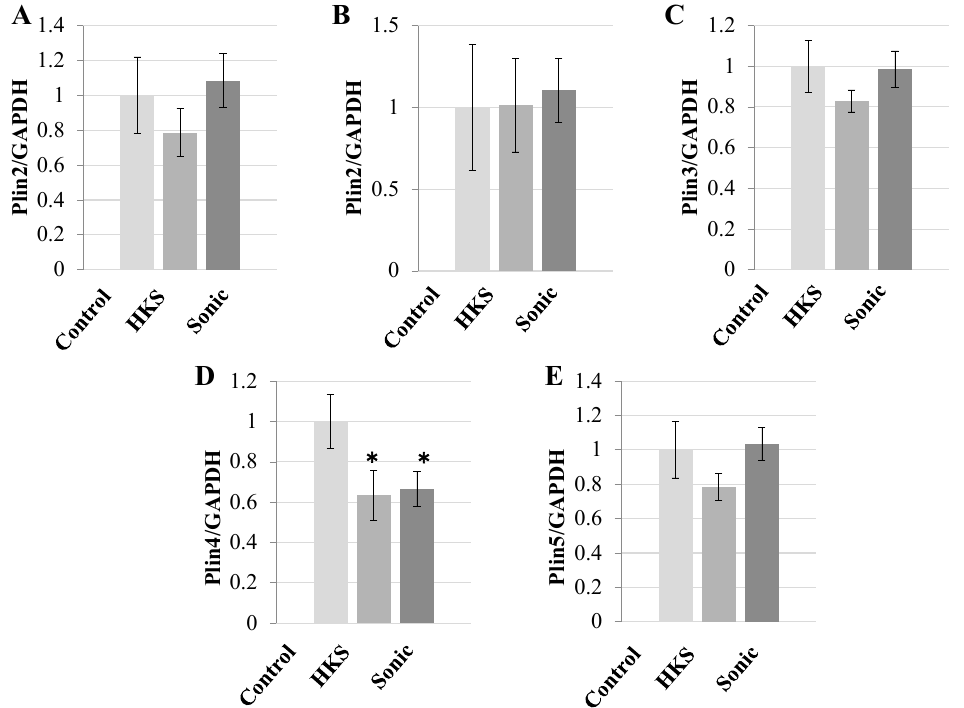
Figure 1. The effects of Bifidobacterium breve MCC1274 extract on perilipin gene expression in SH-SY5Y cells. The SH-SY5Y cells were exposed to B. breve MCC1274 heat-killed supernatant (HKS) or sonicated supernatant (Sonic) for 1 h at a 1% v/v final concentration. The expression of human perilipin mRNA genes relative to human GAPDH by RT-PCR ( A – E ). The data are shown as the mean +/ − standard deviation (SD) of six replicates. * p < 0.05, vs. Control (non-repeated measures ANOVA with the Bonferroni post hoc test).